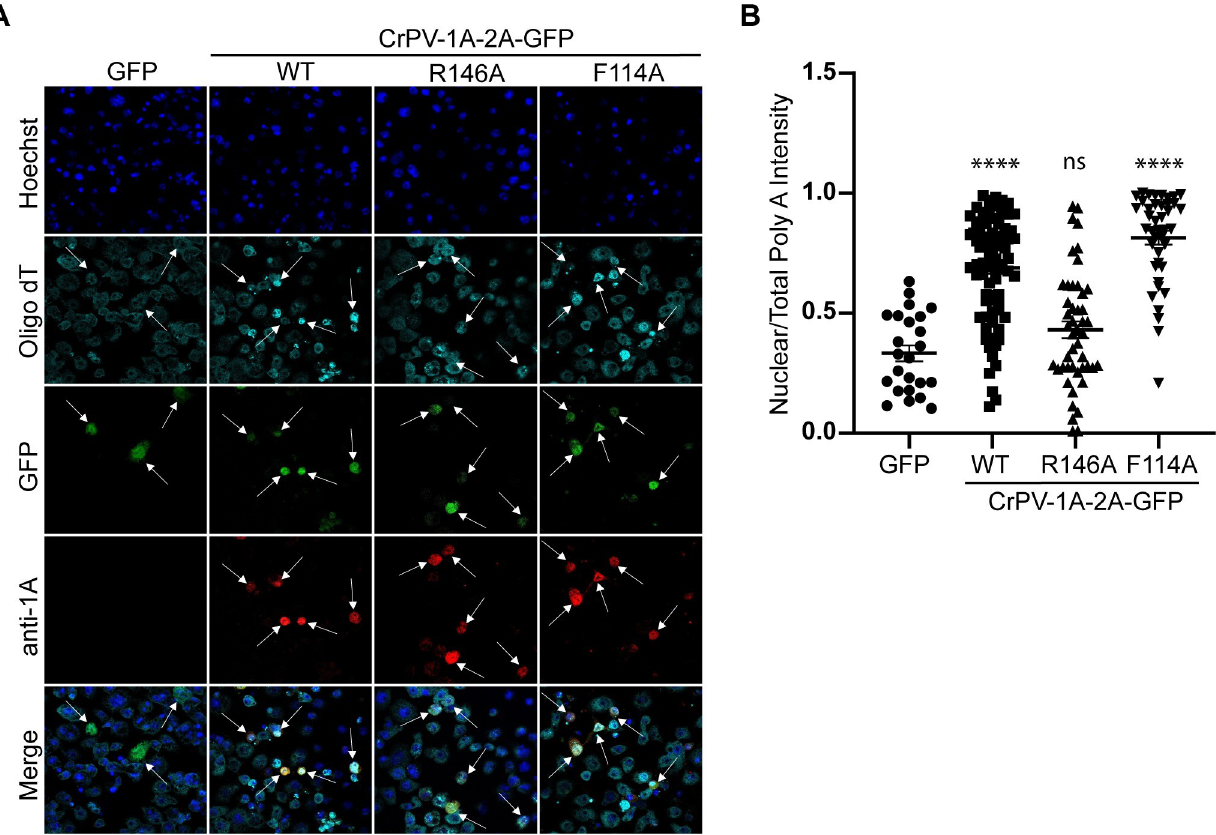
Fig 4. CrPV-1A localizes to the nucleus and induces poly(A)+ RNA accumulation in the nucleus. (A) Confocal immunofluorescence images of S2 cells transfected with in vitro transcribed RNA encoding CrPV-1A, CrPV-1A(R146A), or CrPV-1A(F114A) for 16 hours. GFP fluorescence (green), CrPV-1A antibody staining (red), fluorescence in situ hybridization using Cy5-oligo(dT) probes (cyan) and Hoechst dye (blue). The arrows show transfected cells. Images were taken using the Leica Sp5 confocal microscope with a 63X objective lens and 2X zoom (B) Box plot of the fraction of nuclear to total Cy5-oligo (dT) fluorescence intensity in each cell. At least 50 cells were counted for each condition from two independent experiments. Data are mean ± SD. p > 0.05 (ns), p < 0.021 ( � ), p < 0.002( �� ), p < 0.0001( ���� ) by a one-way ANOVA (nonparametric) with a Bonferroni’s post hoc-test.